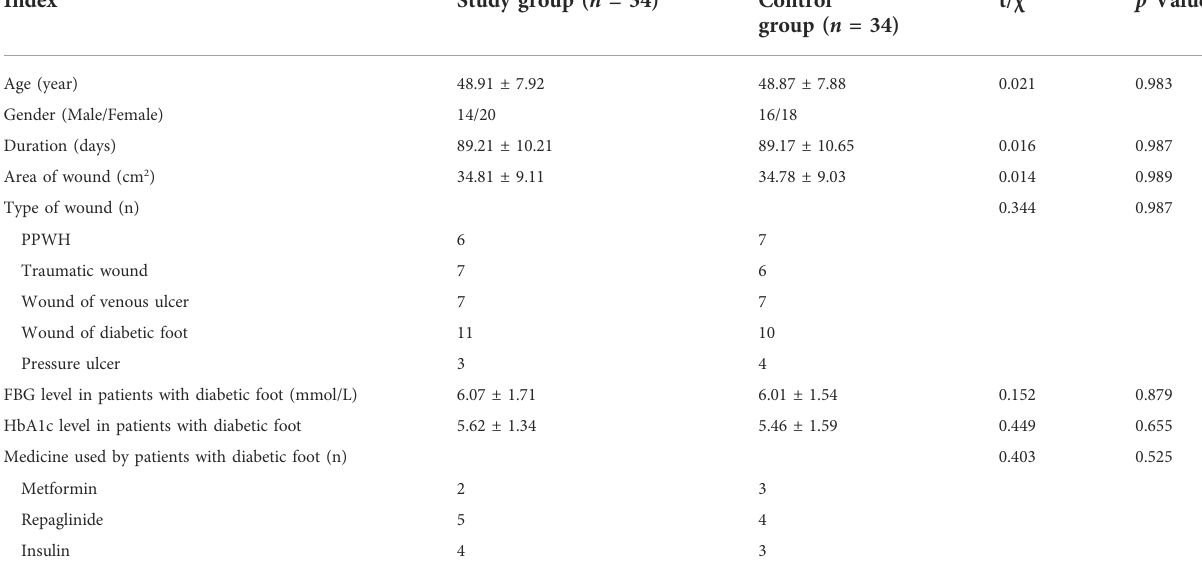
TABLE 1 Comparison of general information between two